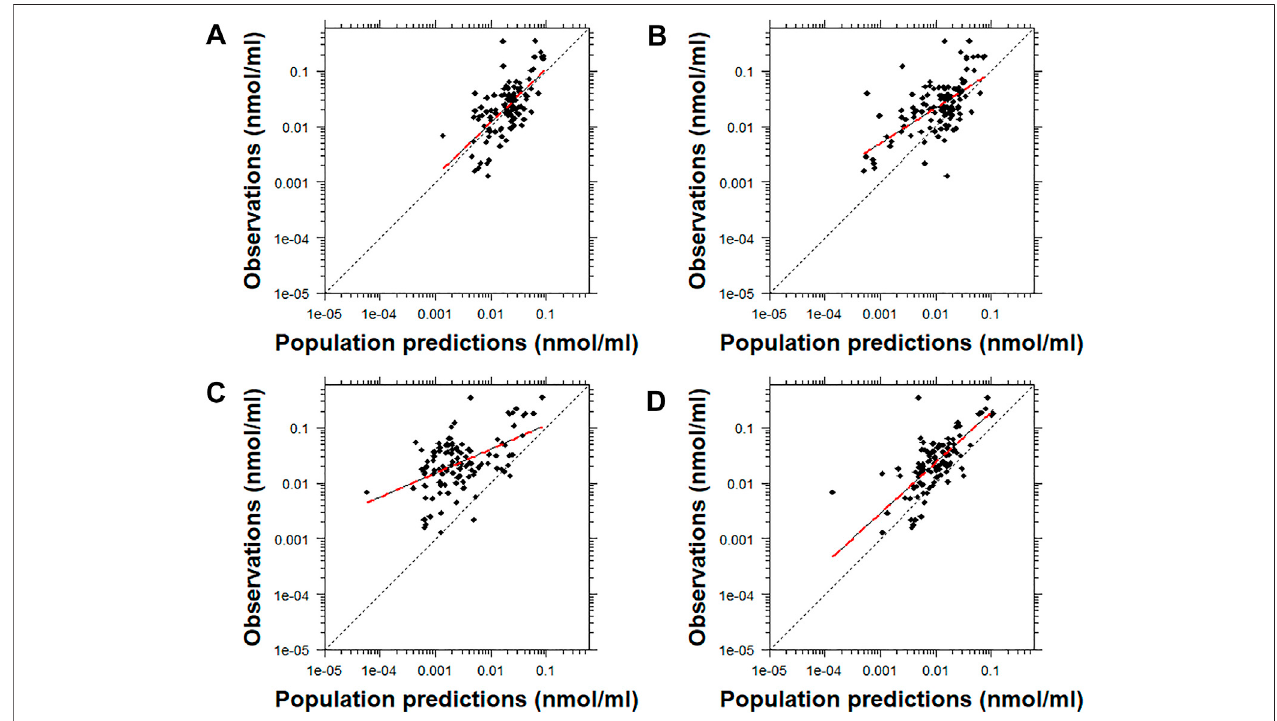
FIGURE 3 | Population predicted concentrations versus observations for the metabolite, 9-OH risperidone. Model (A) : Kloosterboer et al., 2021; Model (B) : Sherwin et al., 2012; Model (C) : Feng et al., 2008; and Model (D) : Feng et al., 2008 with allometric scaling. The dashed black and dashed red lines represent the line of identity and the least-squares regression curve,